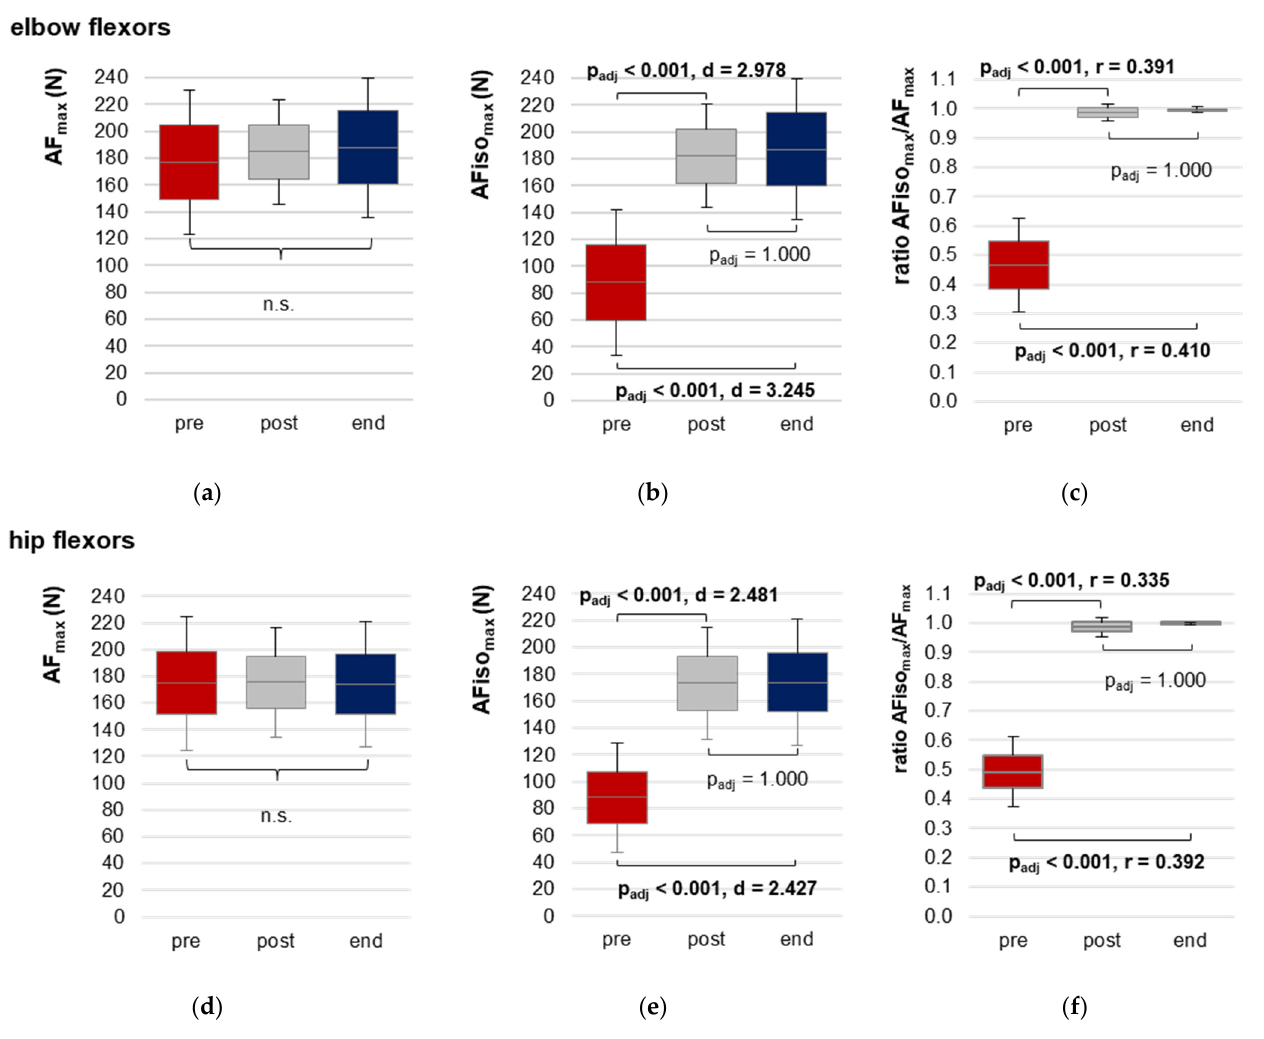
Figure 4. Maximal Adaptive Force and maximal isometric Adaptive Force. Displayed are the arithmetic means, standard deviations (error bars) and 95% CIs of the AF parameters of both muscles at each time point: pre (red), post (grey) and end (blue). Elbow flexors: ( a ) maximal Adaptive Force (AF max ); ( b ) maximal isometric AF (AFiso max ) and ( c ) ratio of AFiso max to AF max ; hip flexors: ( d ) AF max ; ( e ) AFiso max and ( f ) ratio of AFiso max to AF max . The adjusted p -values (Bonferroni correction) for the pairwise comparison of the RM ANOVA, as well as of the Friedman test and the respective effect sizes Cohen’s d or Pearson’s r are given in case of significance.